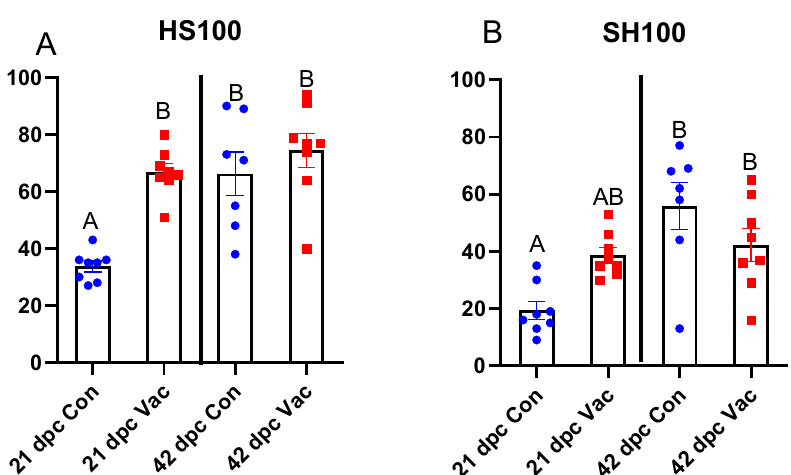
Figure 4. Immunoglobulin sequencing data showing an overlap of repertoires in the heart and spleen of unvaccinated (Con) or vaccinated (Vac) Atlantic salmon 21 and 42 days post-challenge (dpc). ( A ) Occurrence of the 100 most abundant clonotypes in the heart that are also found in the spleen (HS100). ( B ) Occurrence of the 100 most abundant clonotypes in the spleen that are also found in the heart (SH100). Columns not sharing a common letter are significantly different (individual for each figure) ( n = 8, ANOVA, Tukey’s test, p < 0.05).